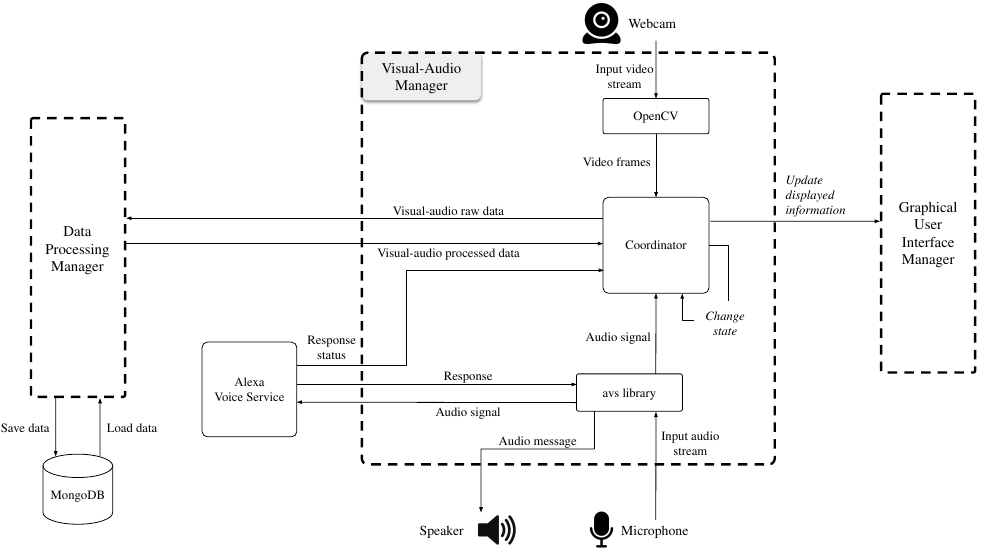
Figure 7. Components and interactions of Visual-Audio Manager in